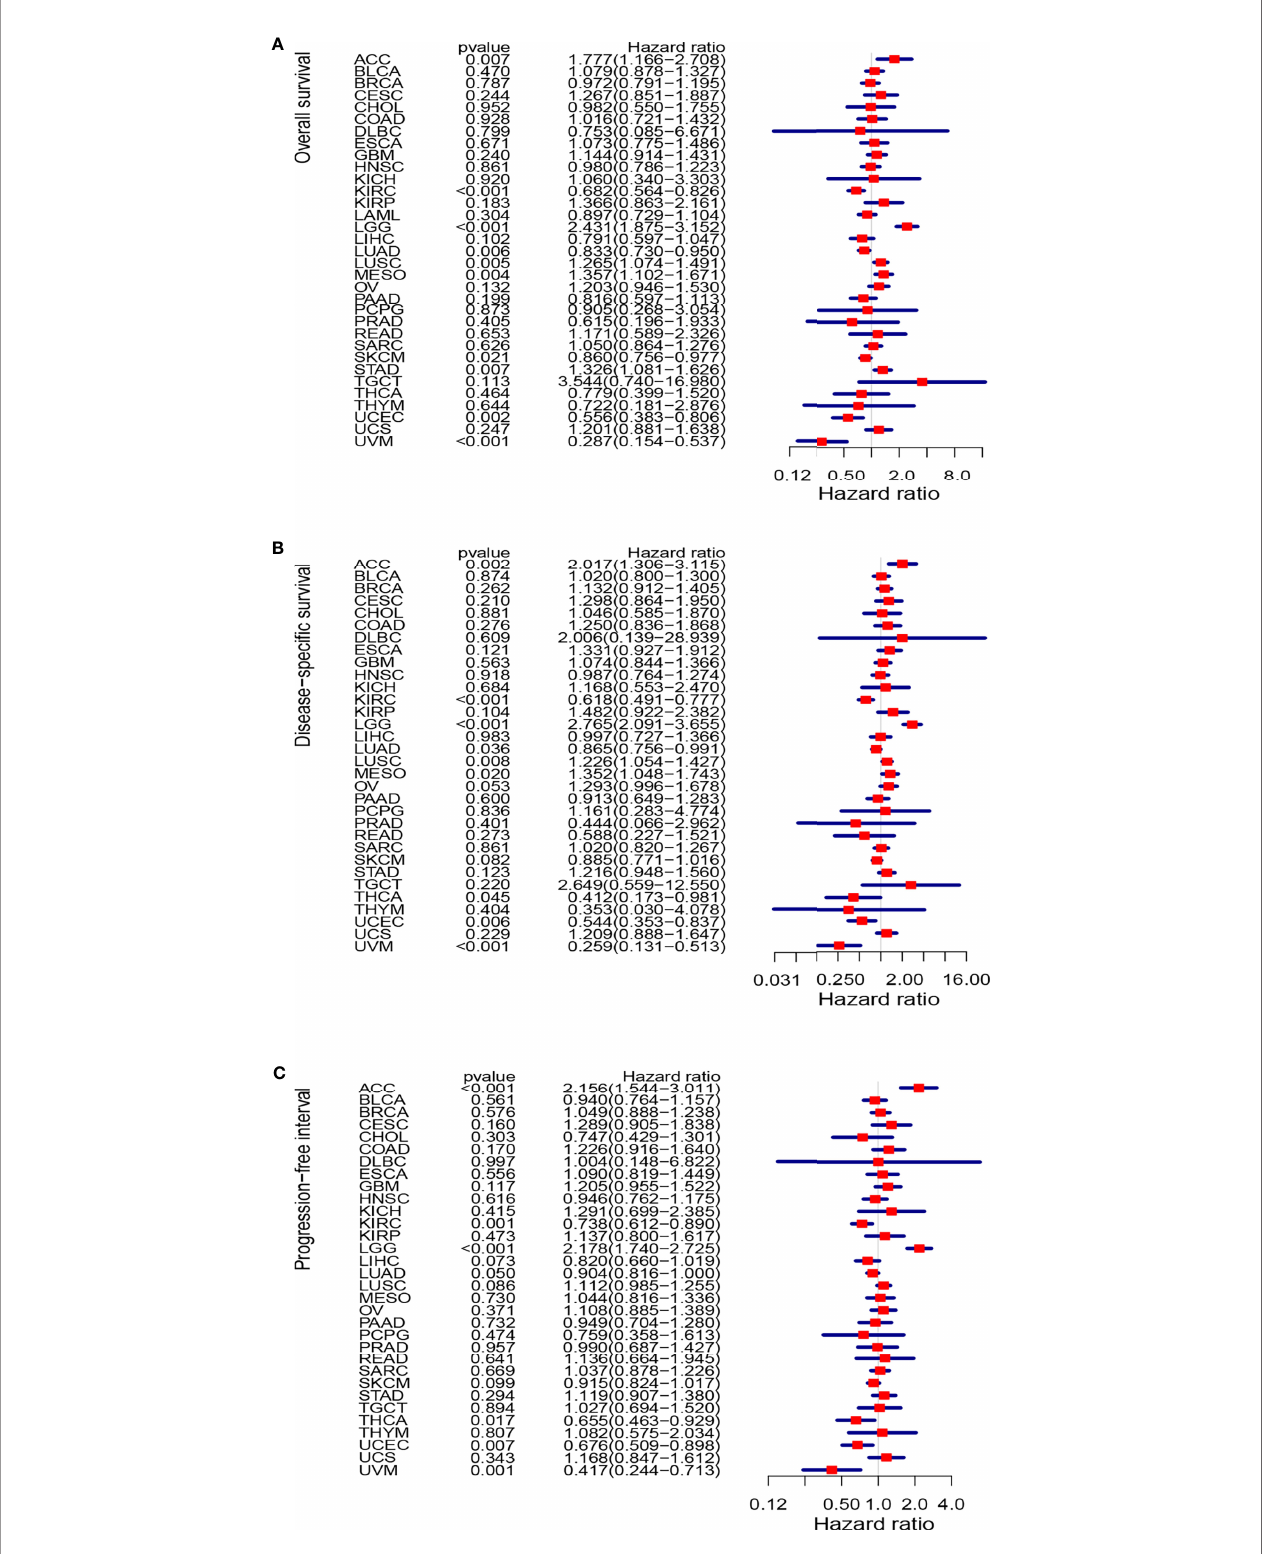
FIGURE 3 | Forest plots of studies investigating the correlation between DLC1 expression and prognosis of various types of cancer in the TCGA database. (A) Forest plots for overall survival; (B) forest plots for disease-speci fi c survival; (C) forest plot for progression-free interval. HR, hazard ratio; CI, con fi dence